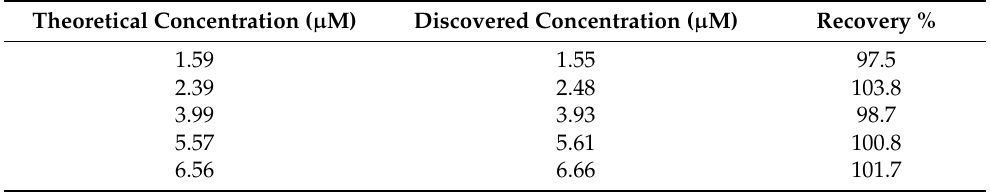
Table 3. Analysis of verbascoside recovery using the standard addition